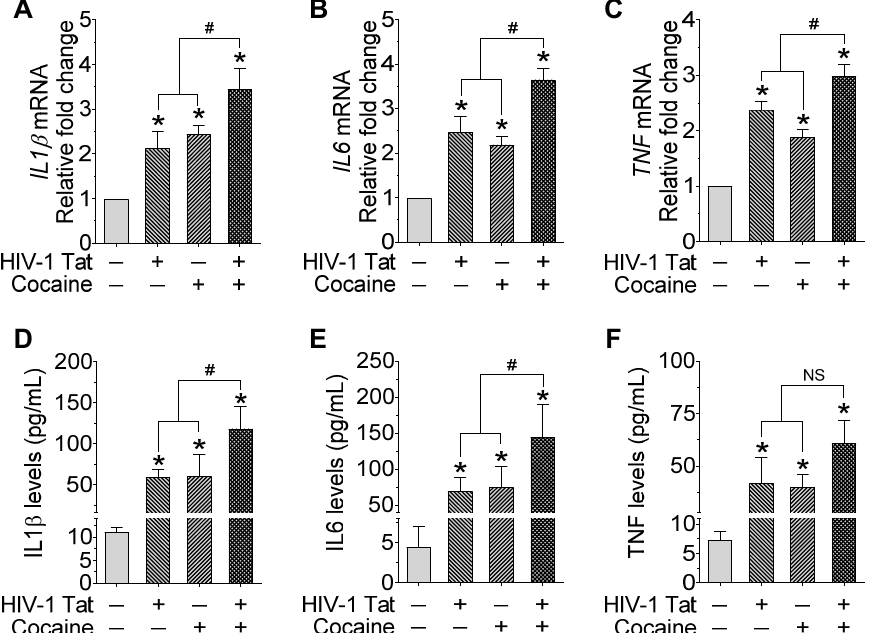
Figure 4. HIV-1 Tat and/or cocaine significantly increased the proinflammatory cytokines in microglia. Representative qPCR analysis showing the expression of IL1 β ( A ), IL6 ( B ), and TNF ( C ) mRNA in HIV-1 Tat (25 ng/mL) and cocaine (10 µ M) exposed mouse primary microglial cells for 24 h. Quantification of IL1 β ( D ), IL6 ( E ), and TNF ( F ) levels using ELISA in HIV-1 Tat (25 ng/mL) and cocaine (10 μ M) exposed mouse primary microglial cells for 24 h. Data are mean ± SEM from six independent experiments. Nonparametric Kruskal–Wallis one-way ANOVA followed by Dunn’s post hoc test was used to determine the statistical significance of multiple groups. * p < 0.05 versus control; # p < 0.05 versus HIV-1 Tat or cocaine; NS, Not significant.